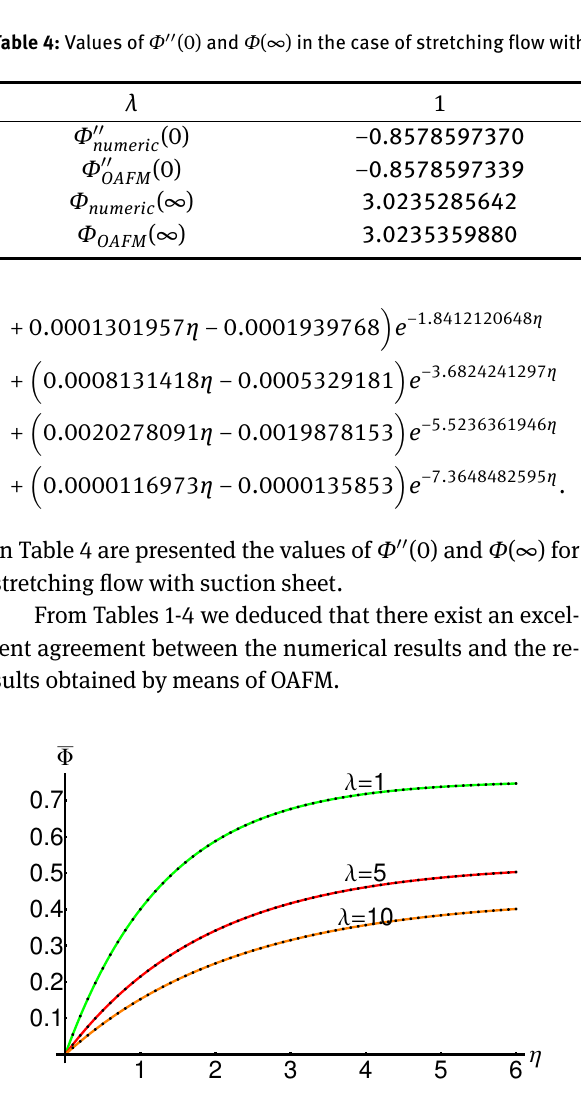
Figure 1: Variation of Φ by increasing the slip parameter λ for planar flow and impermeable sheet ( m = 1, α = 0) : — numerical solution; ...... OAFM solution